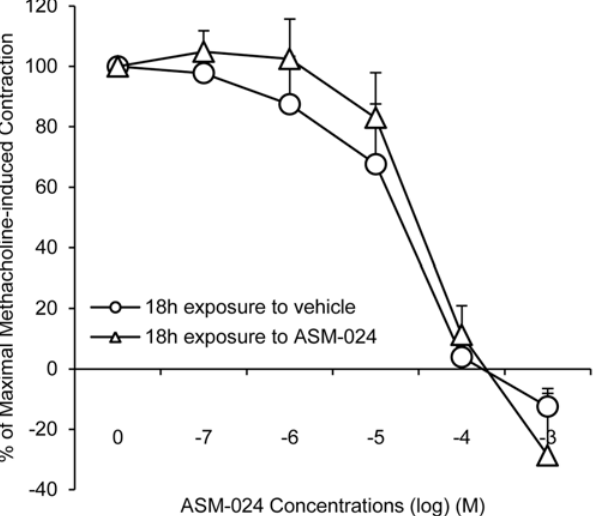
Fig 5. Effect of ASM-024 Pre-Exposure on the Relaxation Response to ASM-024. Guinea pig tracheas were pre incubated for 18h with 5x10-5 M of ASM-024, a concentration that induces 50% relaxation. Prolonged exposure of tracheas to ASM-024 had no significant effect on the responsiveness of the tracheas to subsequent treatment. n = 3 – 4.